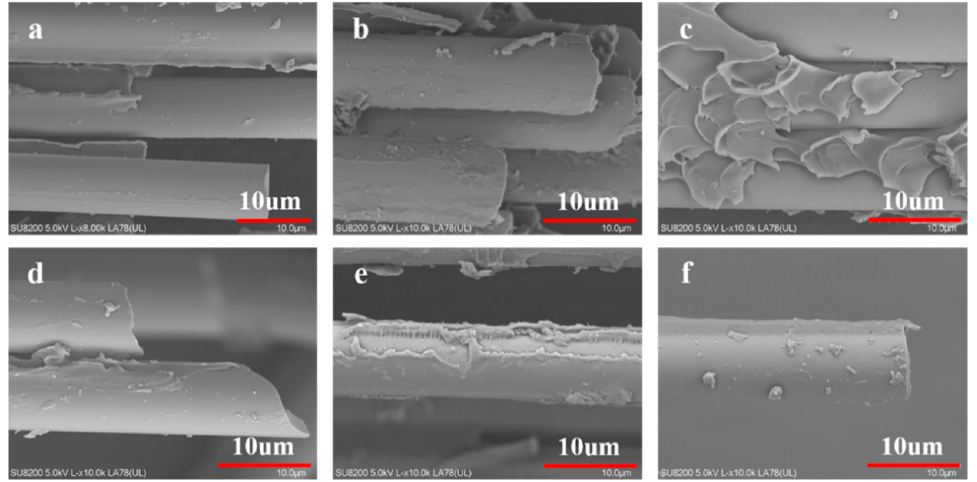
Figure 4. SEM images of tensile test fracture; ( a ) BF—Desized/PPENK, ( b ) BF-PVP/PPENK, ( c ) BF- PEN/PPENK, ( d ) BF-PPEK/PPENK, ( e ) BF-PPEN/PPENK and ( f ) BF-PPENK/PPENK composites.